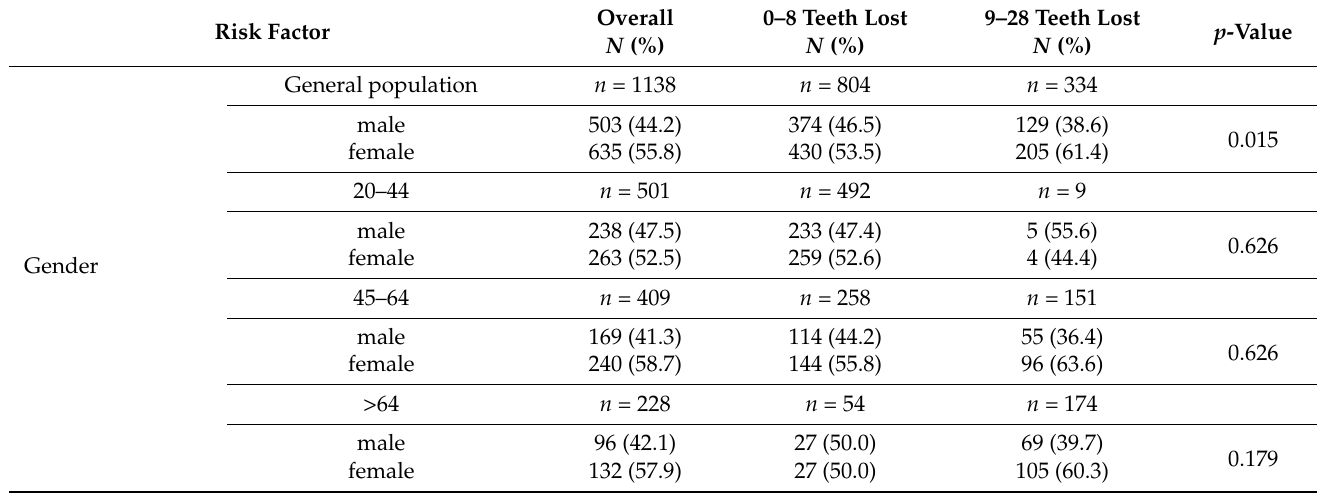
Table 2. Prevalence of tooth loss according to demographic characteristics and smoking and oral